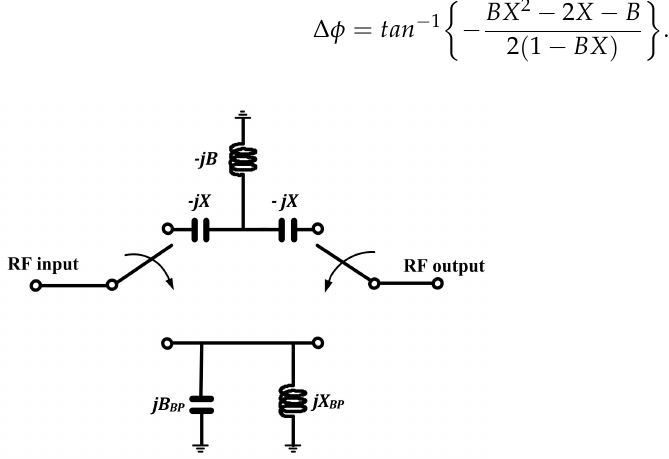
Figure 4. Schematic of the high-pass/band-pass phase